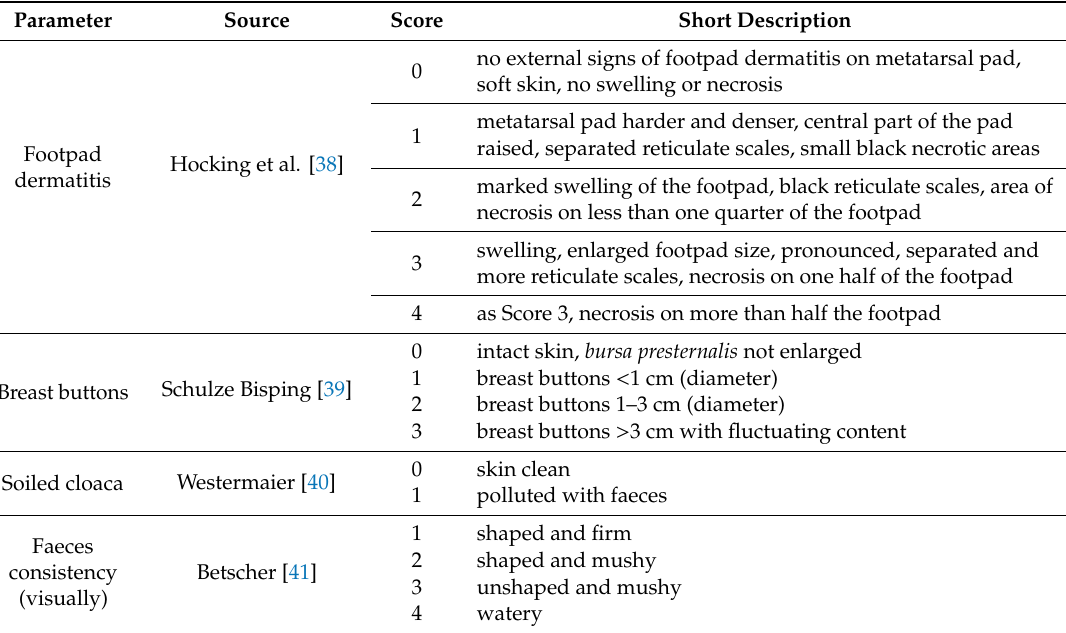
Table 4. Scoring systems used in both experiments for evaluating the health status of the turkey toms during the fattening period, and a short description of the